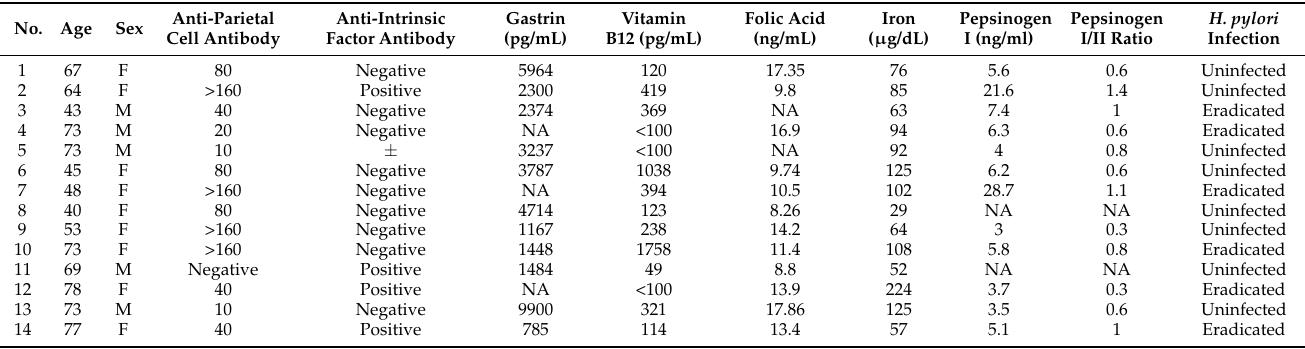
Table 2. Details of the patients with autoimmune